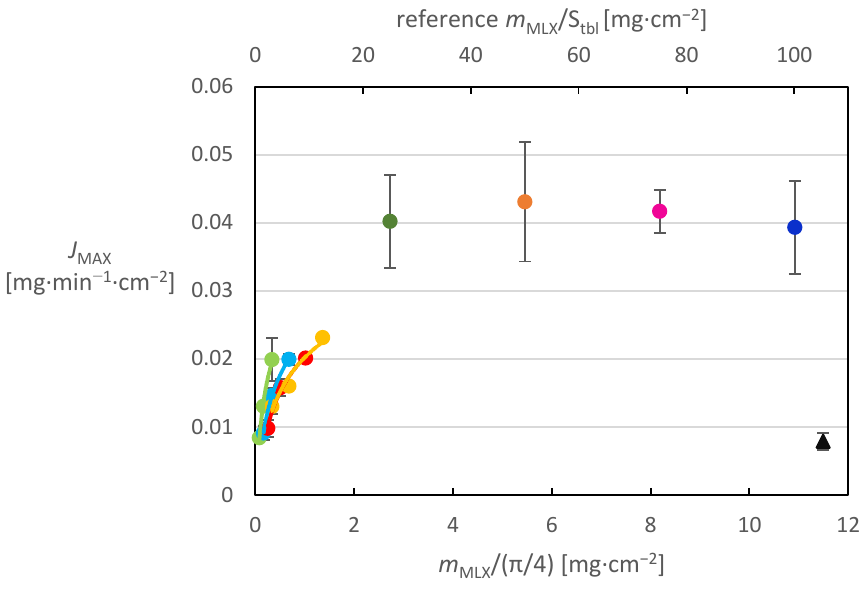
Figure 4. Maximum MX release flux depending on carrier surface coverage by MX (5 drops ■ , 10 drops ■ , 15 drops ■ , 20 drops ■ ); the curves fit the data by logarithmic functions.